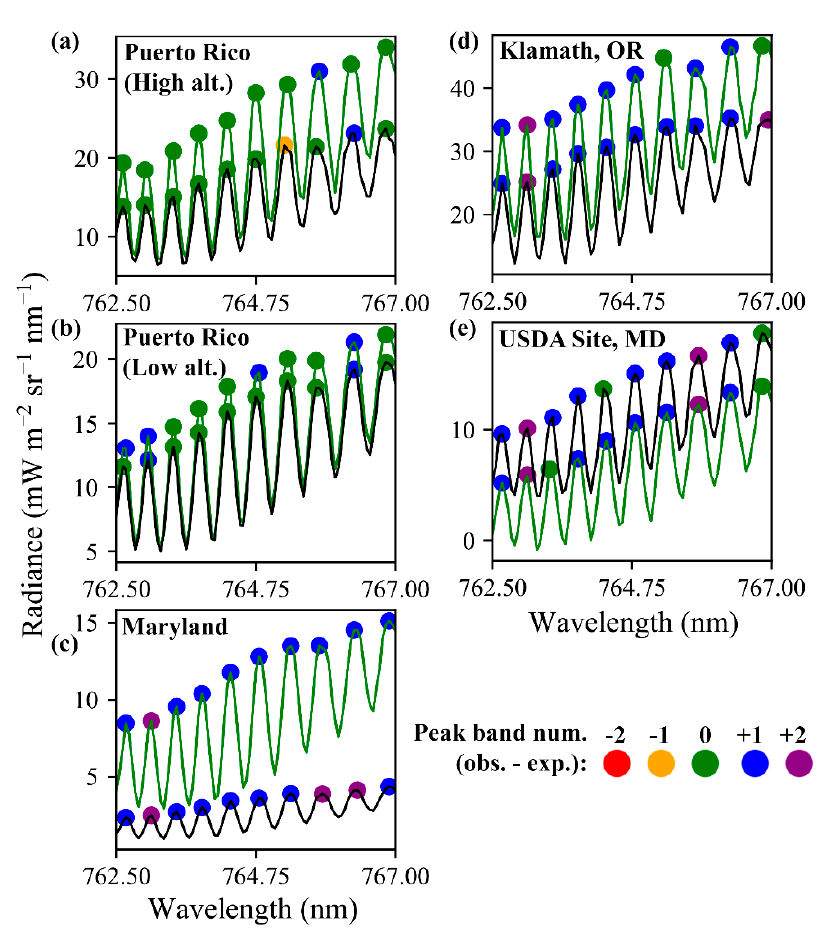
Figure 24. Radiances from vegetated (green line) and non-vegetated (black line) targets for absorption features found in the region of influence of the oxygen A feature. Results for five sets of acquisitions are shown ( a – e ), with the location annotated in each panel. The bands identified as the peak for each absorption feature are shown (circles), and colored according to their distance in bands from the FIREFLY band in which the peak most commonly occurred across all in-flight acquisitions. The Puerto Rico acquisitions were for the same area, but collected at high ( a ) and low ( b ) altitudes, respectively. Spectral smile is the term used when the detected wavelength of energy shifts as a function of the spatial pixel in which it occurs, due to the inconsistent distribution of energy by the detector